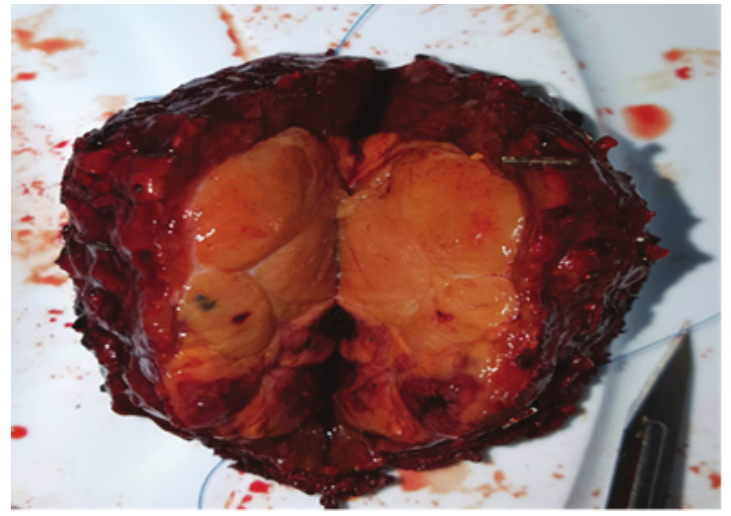
Figure 6: Postoperative adequate resection margins of HCC